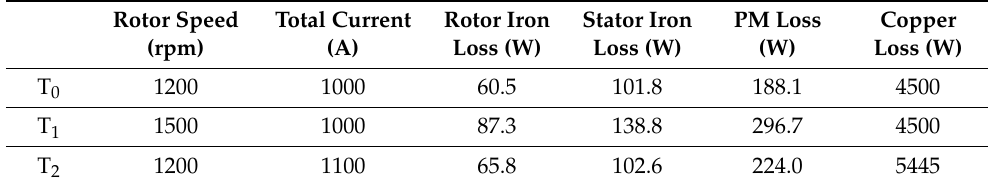
Figure 6. ( a ) grid structure; ( b ) convective flow regions in motor; ( c ) grid dependency test result. Table 2. Rotor iron loss, stator iron loss, PM loss, and copper loss at the operating conditions T 0 –T 1 with the specific rotor speeds and total electric